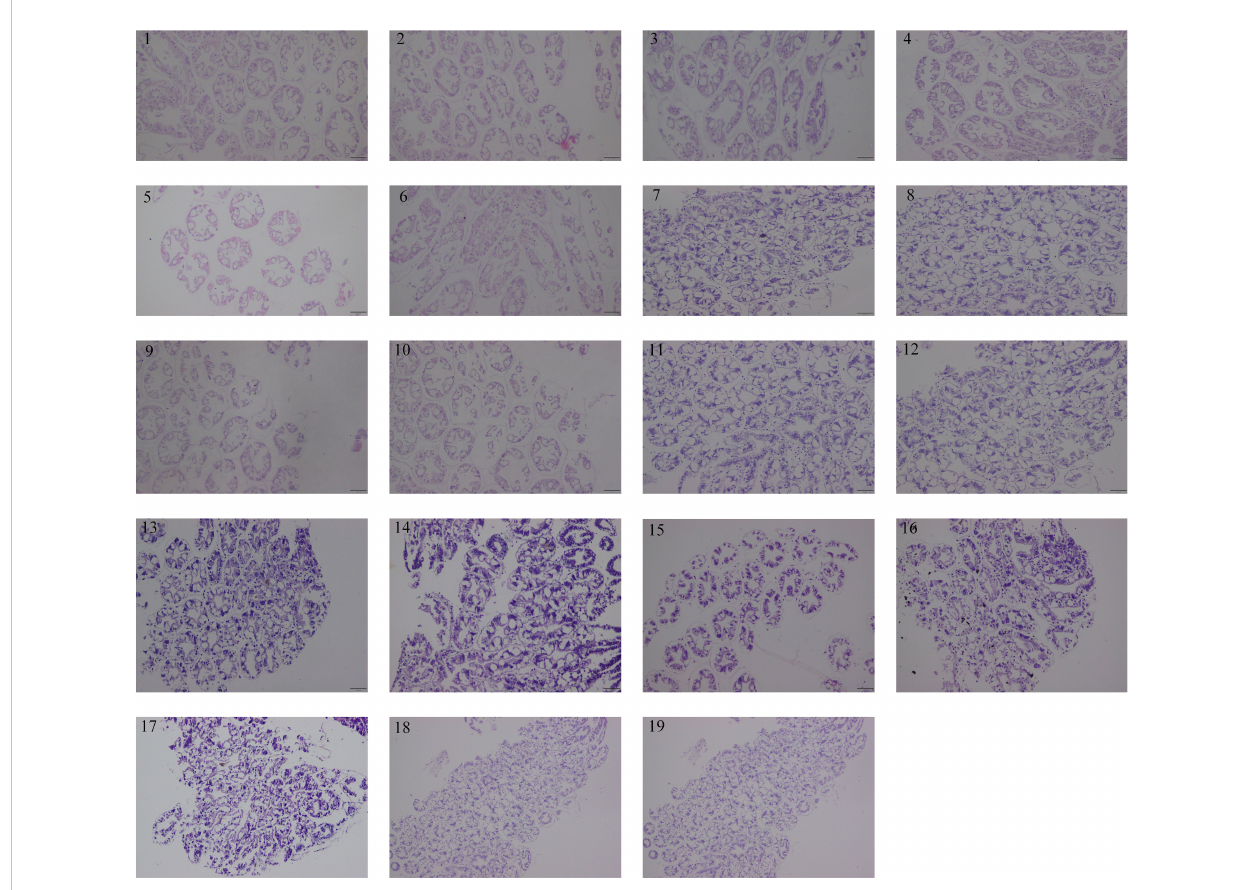
FIGURE 3 Hepatopancreas histomorphology of shrimps from each group at 14 days. All sections were stained with H&E. Scale bar 100µm. 1. CpG ODN 1826, 2. CpG ODN 1681, 3. CpG ODN 2006, 4. CpG ODN M362, 5. CpG ODN 2137, 6. CpG ODN 8954, 7. CpG ODN 1585, 8. CpG ODN 2143, 9. CpG ODN 2395, 10. CpG ODN 2216, 11. CpG ODN 23617, 12. CpG ODN 2429, 13. CpG ODN 21424, 14. CpG ODN 21425, 15. CpG ODN 21426, 16. CpG ODN 2243, 17. CpG ODN 1720, 18. Negative control 1, 19. Negative control